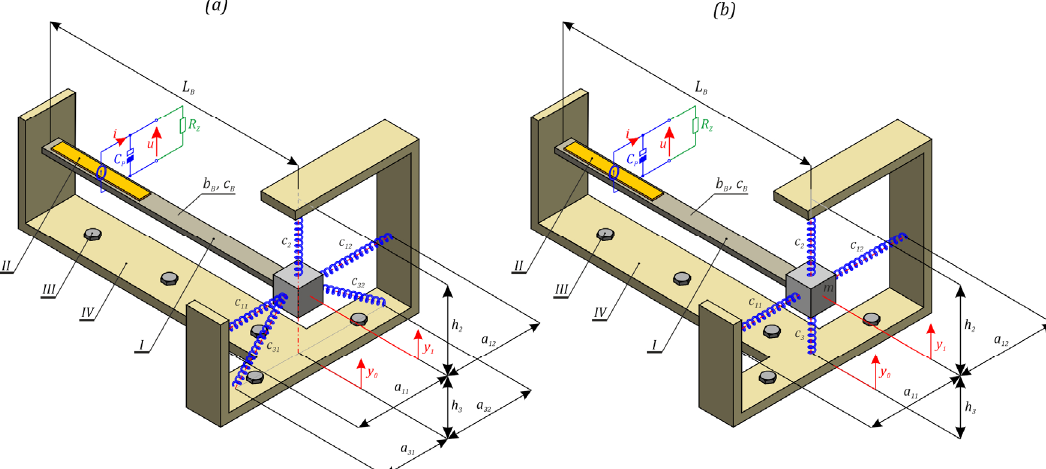
Figure 1. Schematic diagram showing the tested design solutions of an energy harvesting system: ( a ) Asymmetric, ( b ) Symmetric (with respect to the vertical direction) .